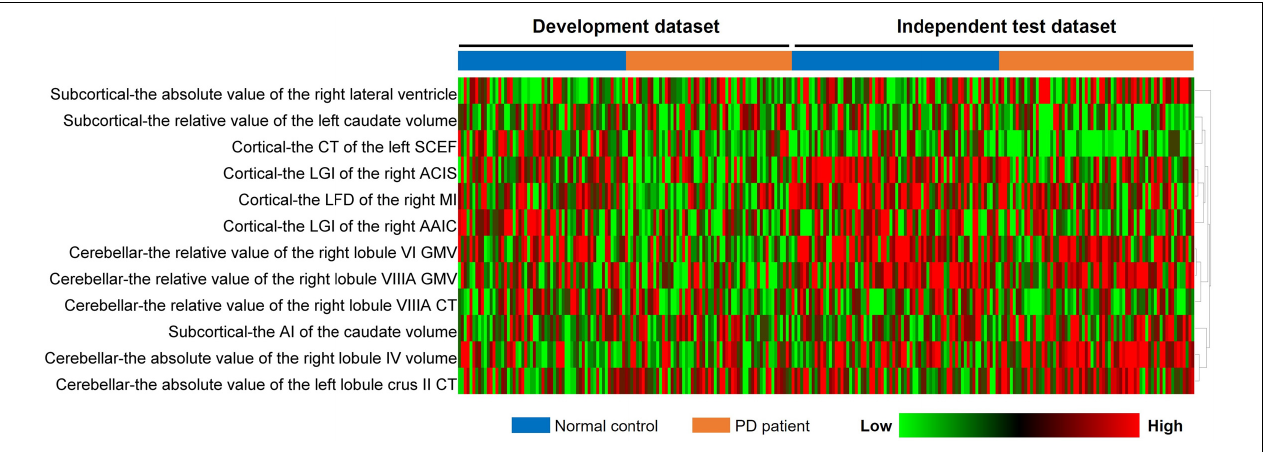
FIGURE 3 | Heatmap analysis of the selected features in both datasets. Each column corresponds to one label (PD or NCs), and each row represented a structural feature; red represents a relatively high feature value, and the green represents a relatively low feature value. PD, Parkinson’s disease; NC, normal control.